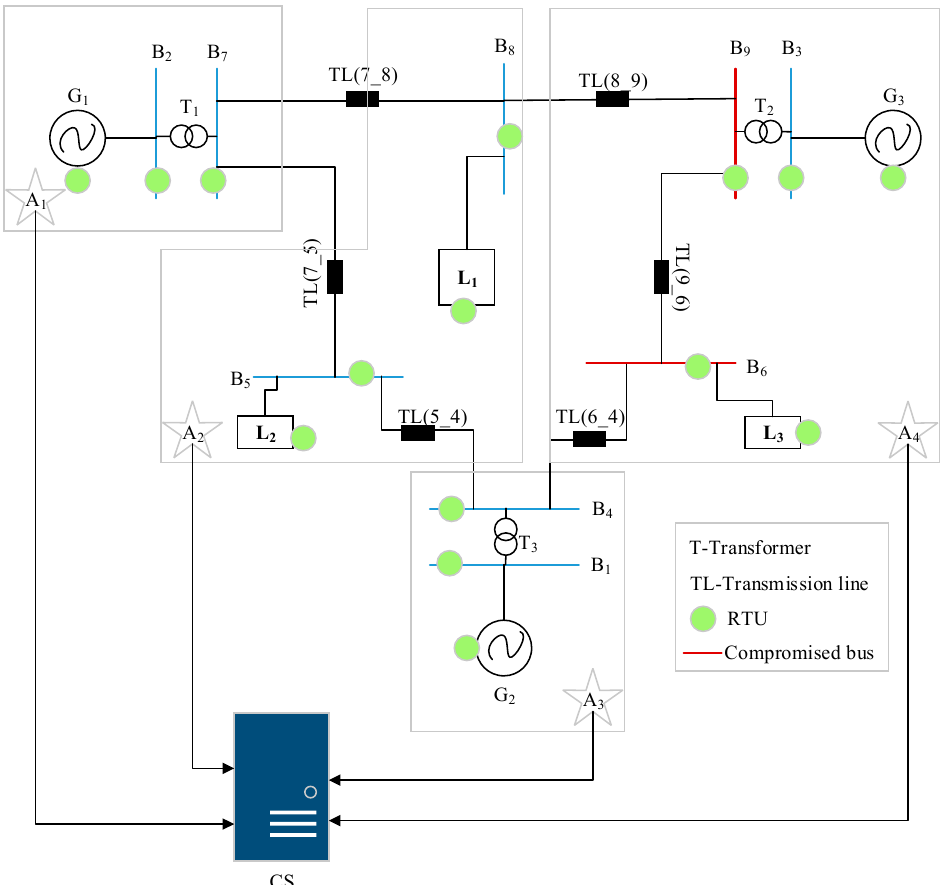
Figure 7. The T 2 S 2 G system based on the IEEE-9 bus system. Table 3. Simulation